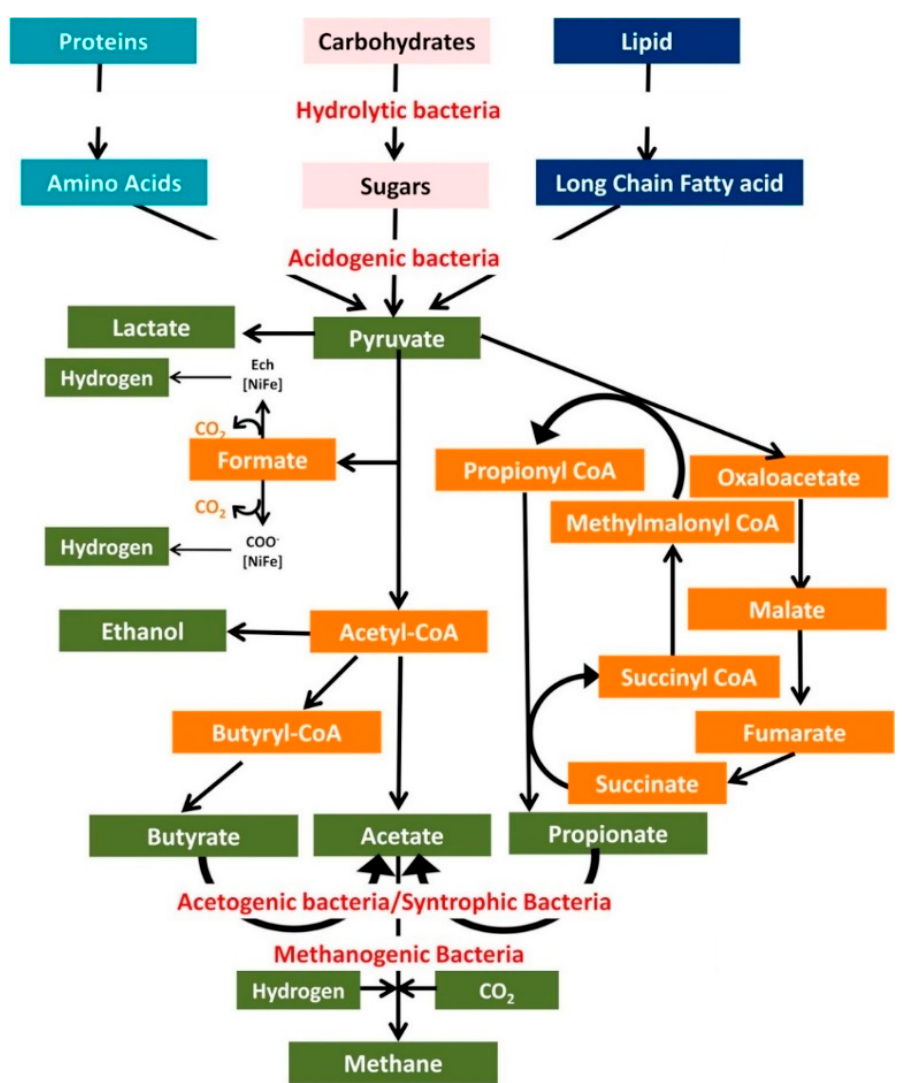
Figure 1. Set of metabolic reactions constituting the anaerobic digestion process. Reprinted with permission from [13]; published by Elsevier, 2018.